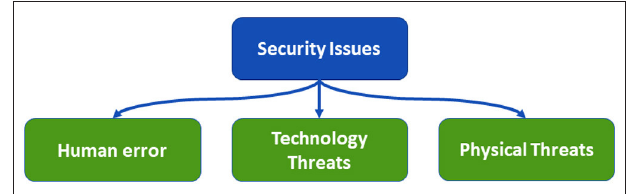
FIGURE 2 | The main categories of security